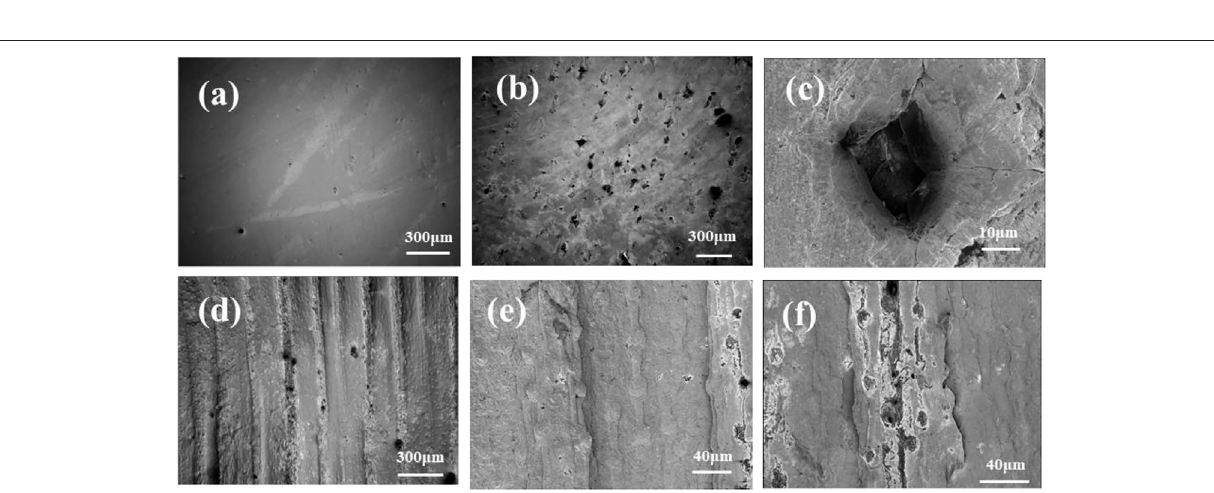
FIGURE 3 | The test platform of IPMC sensor. (A) The setup for sensing performance measuring. (B) The schematic diagram of the cantilever con fi guration.